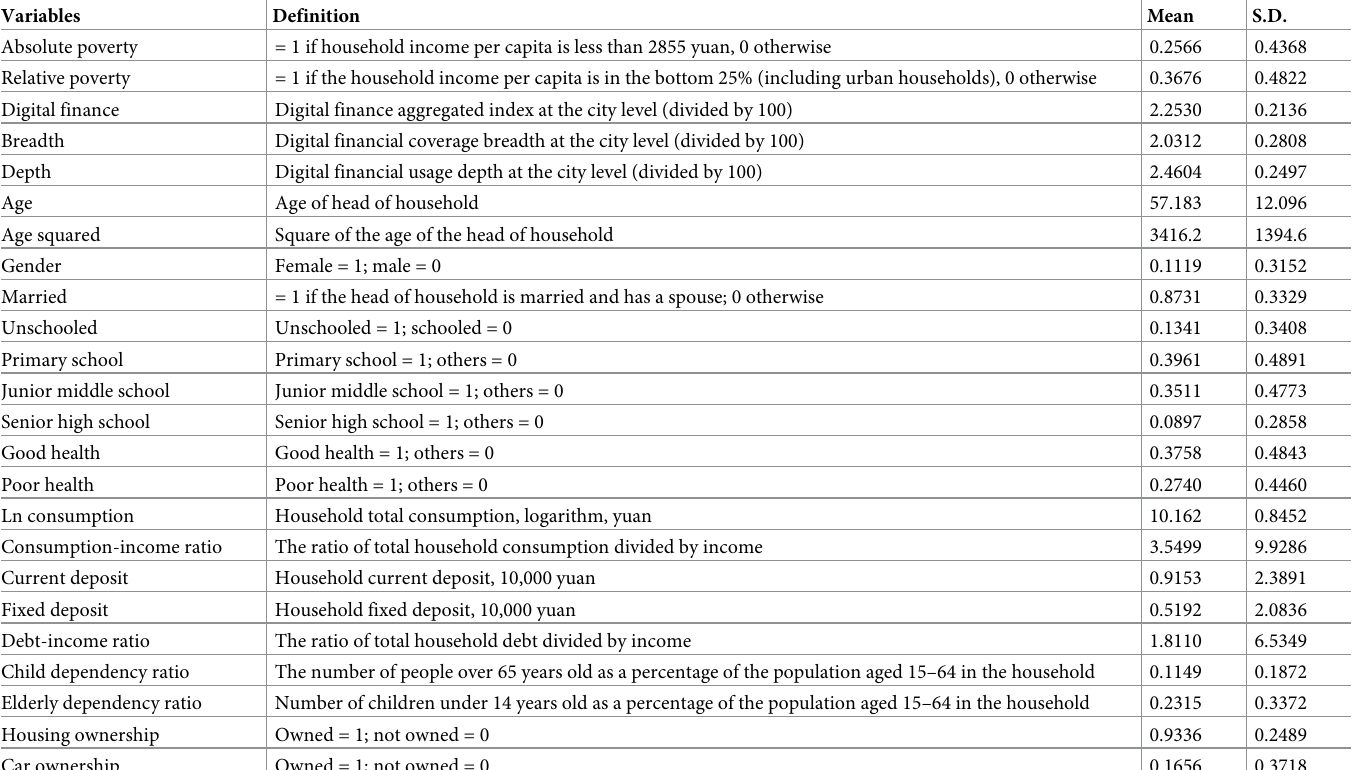
Table 2. Variable definition and descriptive statistics (N =